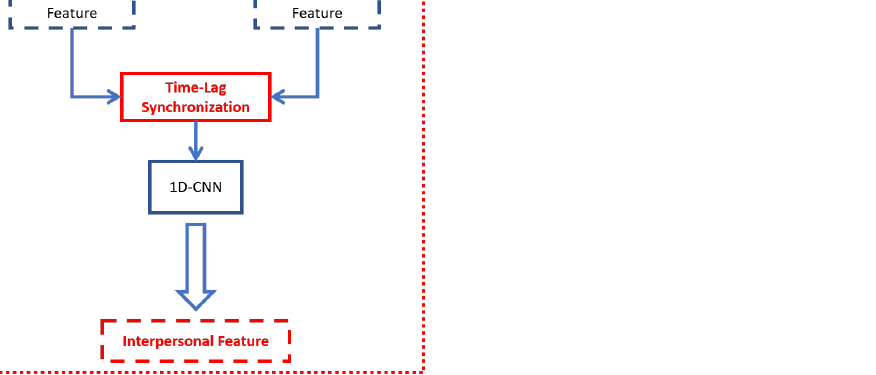
Figure 6. Synchronization model for visual